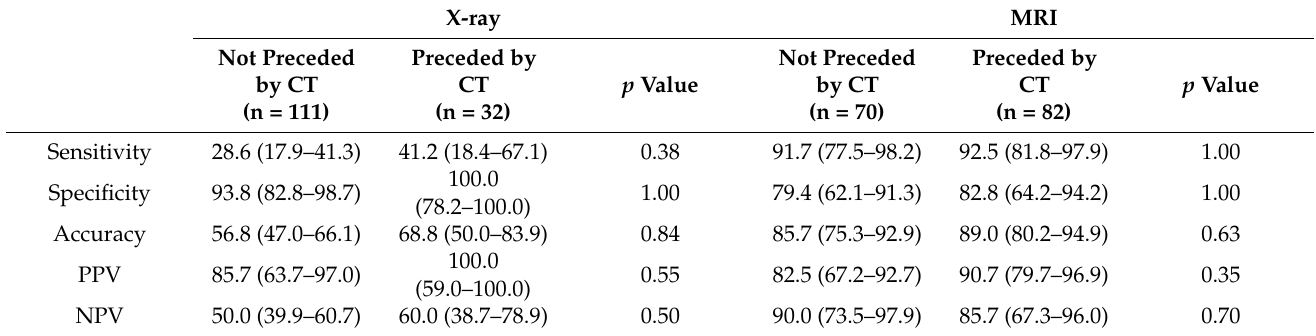
Table 4. Sensitivity, specificity, accuracy, PPV and NPV estimates (reported with 95% confidence intervals) for X-ray and MRI without or with access to a preceding CT.